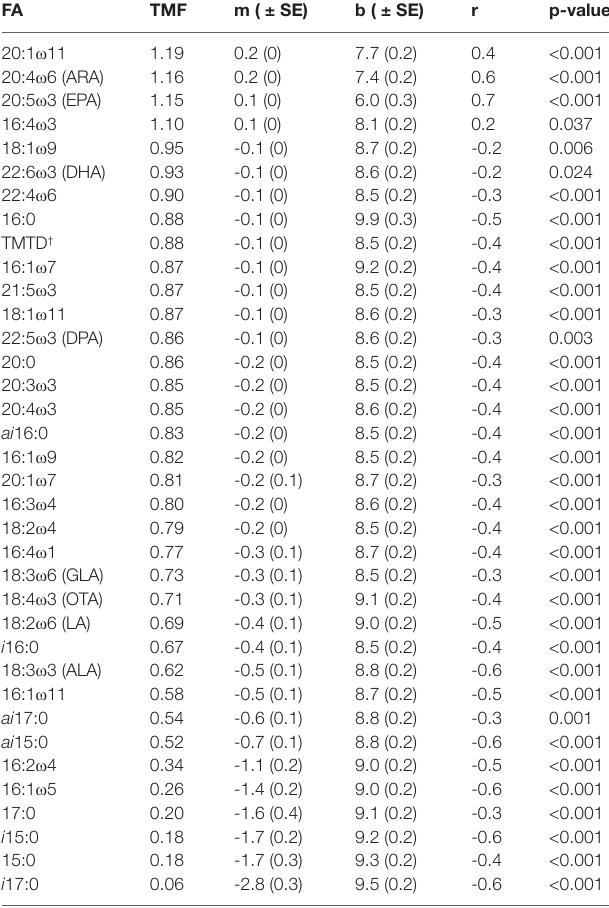
Table 1 for species list) sampled in the South site (see Figure 1A ) were included in the analysis. Nereis spp. was not included because of insufficient tissues for quantification. Only FA with a statistically significant correlation coefficient (r) are